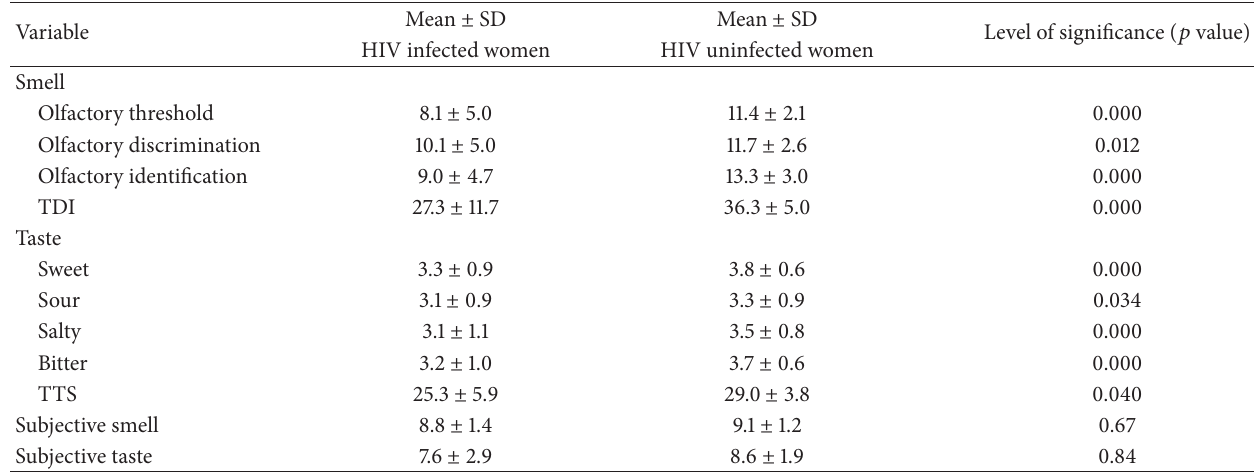
Table 2: Comparison of smell and taste of the participants.